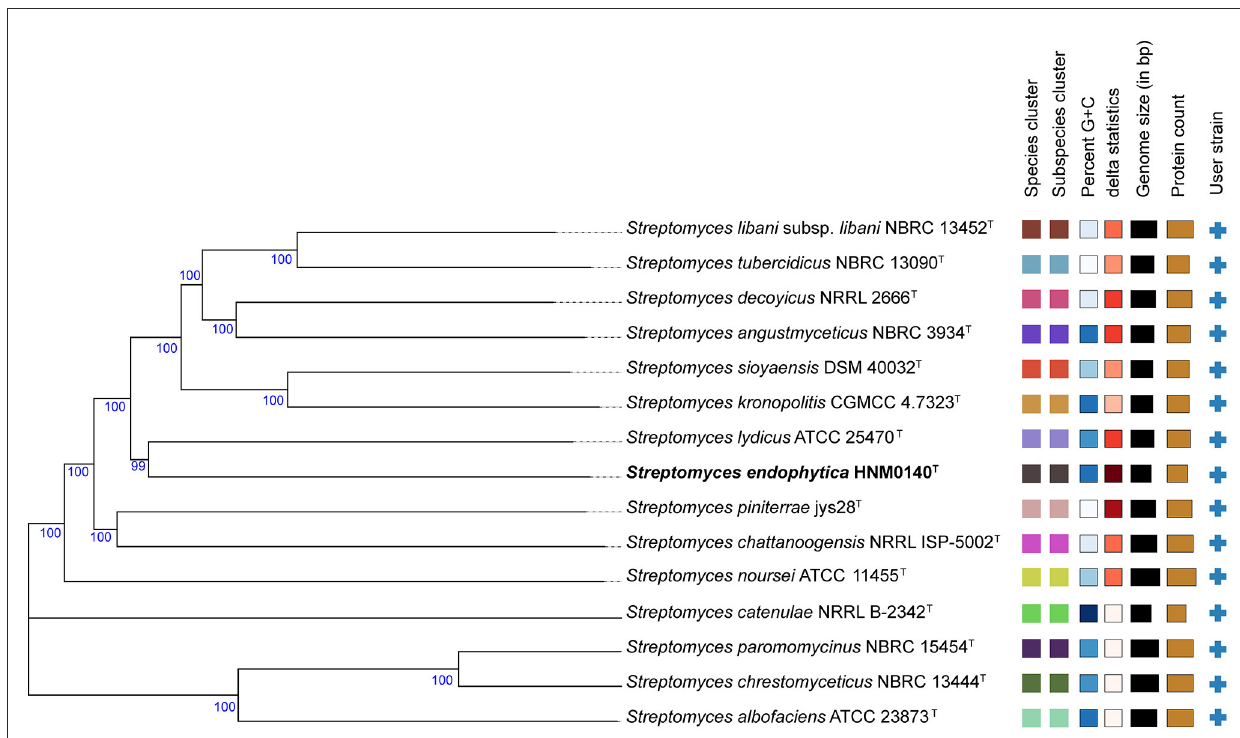
FIGURE5 Phylogenomic tree of strain HNM0140 T reconstructed on the TYGS (https://tygs.dsmz.de/). Tree inferred with FastME 2.1.6.1 from genome blast distance phylogeny (GBDP) distances calculated from genome sequences. The branch lengths are scaled in terms of the GBDP distance formula d 5 . The numbers above branches are GBDP pseudo-bootstrap support values > 60% from 100